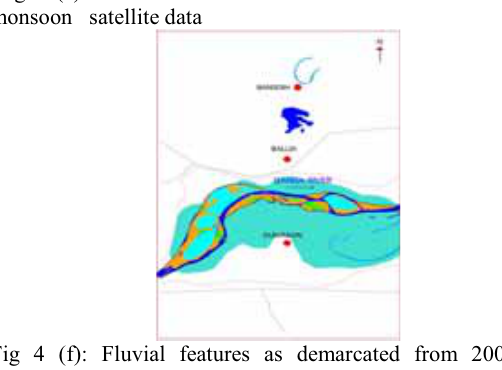
Fig 4 (e): Fluvial features as demarcated from 2004 post-